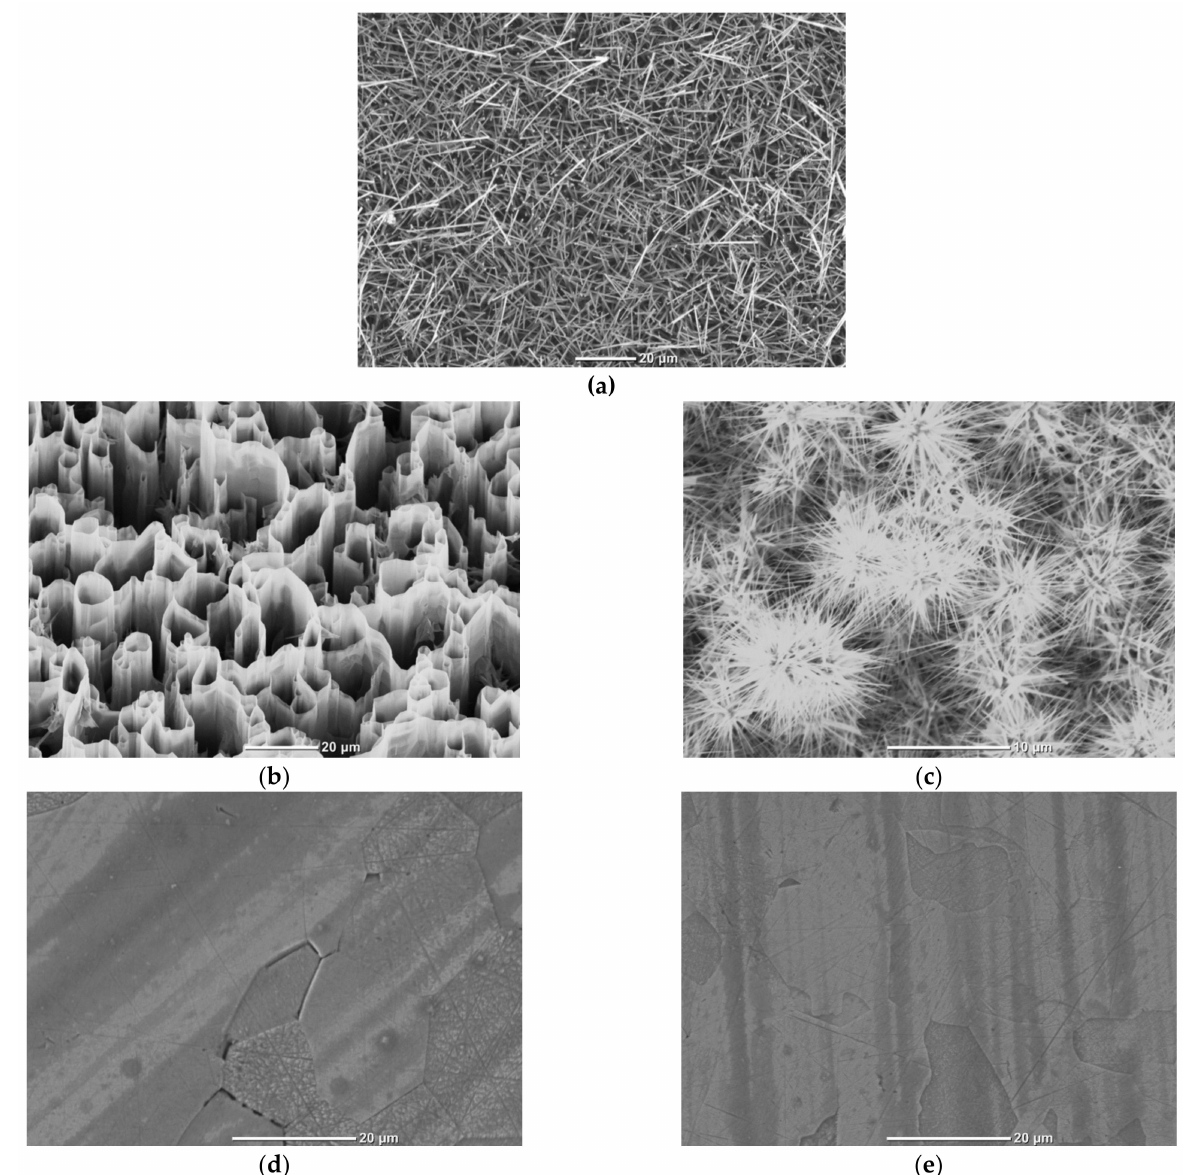
Figure 1. SEM-images of studied ZnO samples: ( a ) whiskers; ( b ) nanowalls; ( c ) multipods; ( d ) undoped ceramics; ( e ) 0.075 wt.% Ga doped